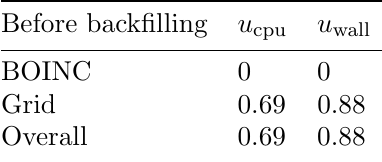
Table 4. CPU Utilization of TRIUMF site before and after